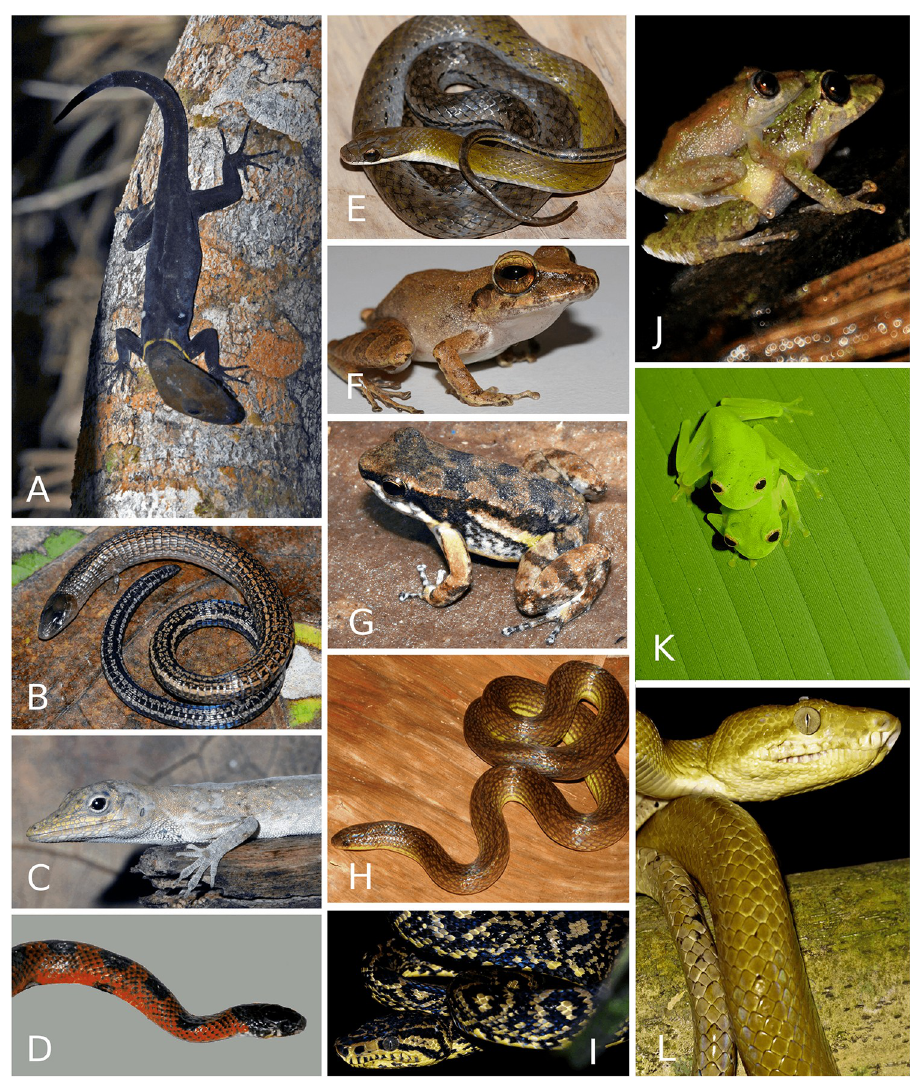
Fig 11. Amphibians and reptiles found on Tobago. A. The Ocellated Day Gecko, Gonatodes ocellatus . B. Square- scaled Bachia, Bachia whitei (Tobago endemic). C. Tobago Anole, Anolis cf tigrinus . D. Red Snake, Erythrolamprus ocellatus (Tobago endemic). E. Tobago Stream Snake, Erythrolamprus pseudoreginae (Tobago endemic). F. Charlotteville Litter Frog, Pristimantis charlottevillensis (Tobago endemic). G. Tobago Stream Frog, Mannophryne olmonae (Tobago endemic). H. Forest Ground Snake, Atractus fuliginosa on Tobago and in north central Venezuela. I and L Ruschenberger’s Treeboa, Corallus ruschenbergerii (different color morphs), J. Turpin’s Litter Frog, Pristimantis turpinorum (Tobago endemic). K. the Coastal Glassfrog, Hyalinobatrachium orientale (Tobago and northcentral Venezuela). Photo credits John C. Murphy (A-C, E-G, I-L), Richard M. Lehtinen (D), and Alvin L. Braswell (H).